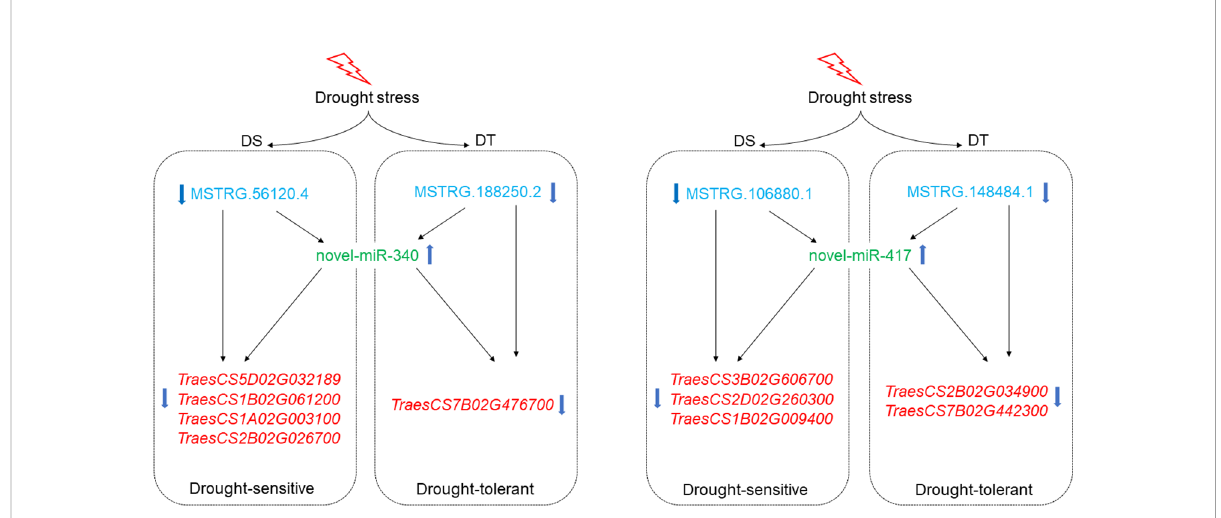
FIGURE 9 Prediction of the regulatory patterns of two candidate lncRNA-miRNA-mRNA modules in the two wheat